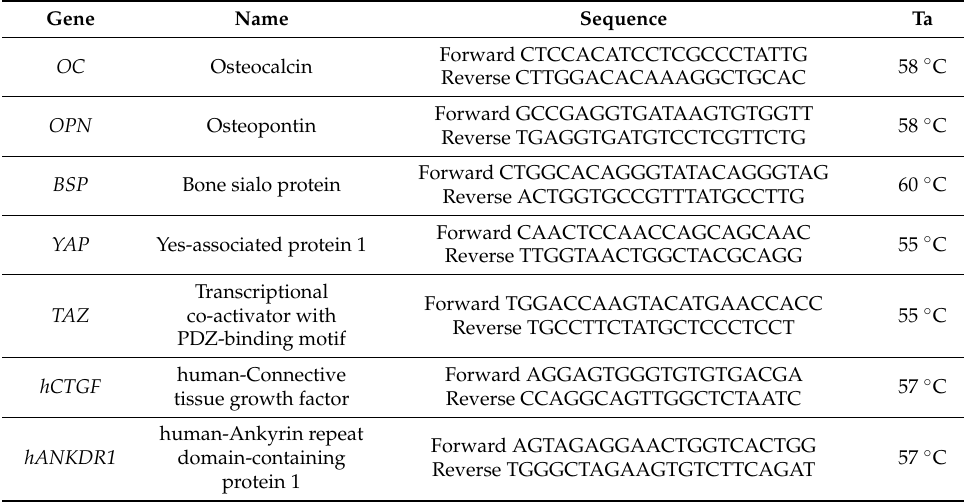
Table 1. Oligonucleotide sequences used for quantitative